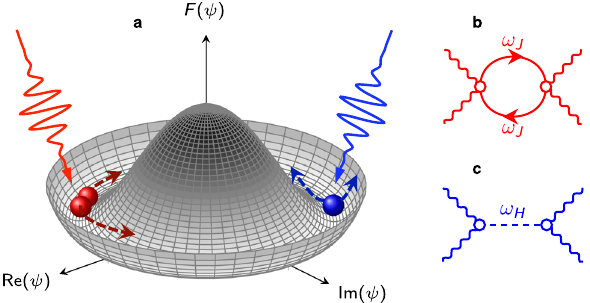
Fig. 1 Non-linear excitation of phase and Higgs modes. a Schematic view of the mexican-hat potential for the free energy F ( ψ ), with ψ the complex order parameter of a superconductor below T c . A phase-gradient excitation corresponds to a shift along the minima, whereas a Higgs excitation moves the system away from the minimum. An intense light pulse with almost zero momentum can excite simultaneously two plasma waves with frequency ω J and opposite momenta (in red) or a single Higgs fl uctuation with frequency ω H = 2 Δ (in blue). b – c Feynman-diagrams representation of the b plasma waves or c Higgs contribution to the non-linear optical response. Here wavy lines represent the e.m. fi eld, solid/dashed lines the plasmon/Higgs fi eld,